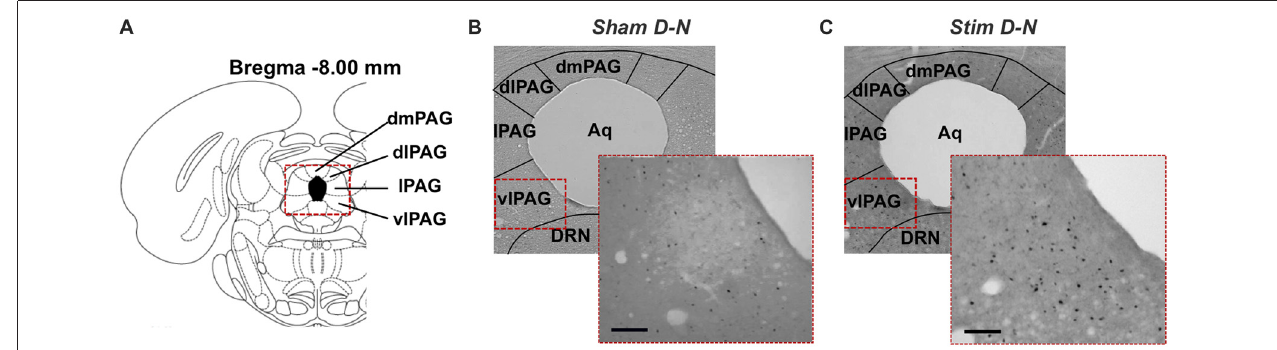
FIGURE 5 | Distribution of cFos immunoreactive cells in the caudal PAG. (A) Coronal diagram of the rat brain at corresponding Bregma level AP − 8.00 mm (Rat brain atlas, Paxinos and Watson, 2007). Representative low power photomicrographs of coronal brain sections stained for cFos showing the PAG of (B) non-stimulated (Sham) rat and (C) stimulated rat (Stim) with bipolar stimulation electrode implanted in the bladder wall at the dome and neck levels. The higher power photomicrographs in the lower right corners focus on the central region of the vlPAG column. Aq, aqueduct; DRN, dorsal raphe nucleus; dlPAG, dorsolateral PAG; dmPAG, dorsomedial PAG; lPAG, lateral PAG; vlPAG, ventrolateral PAG. Scale bar = 100 µ m.